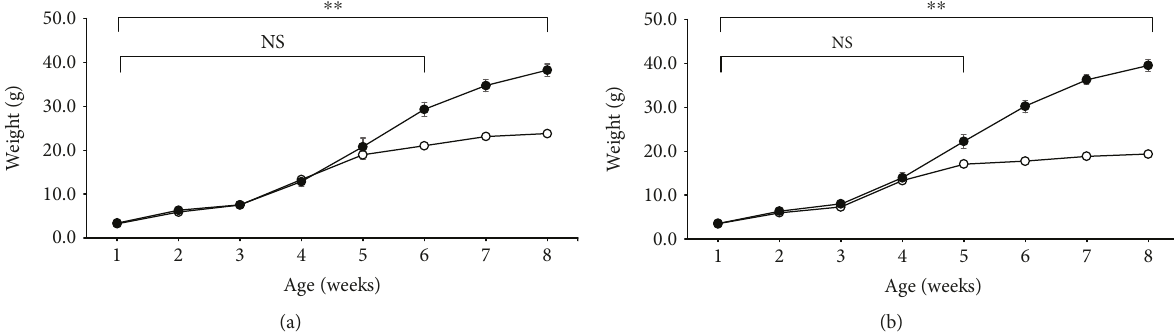
Figure 1: Body weight (BW) change during development. Weekly BWs of male (a) and female mice (b) are displayed. Open symbols represent WT ( +/+ ) mice, and closed symbols represent db/db mice. The sample size of all groups is 6. The values are the mean ± SE. The data were analyzed statistically by two-way (repeated measurement) ANOVA. ∗∗ P < 0 01 compared with WT mice. NS: not signi fi